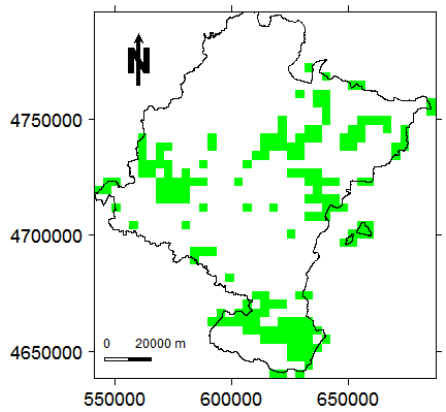
Figure 14. Locations with significant change-points detected by the Strucchange method for LST night remote sensing data of Navarre, Spain, from January 2001 to December 2018.